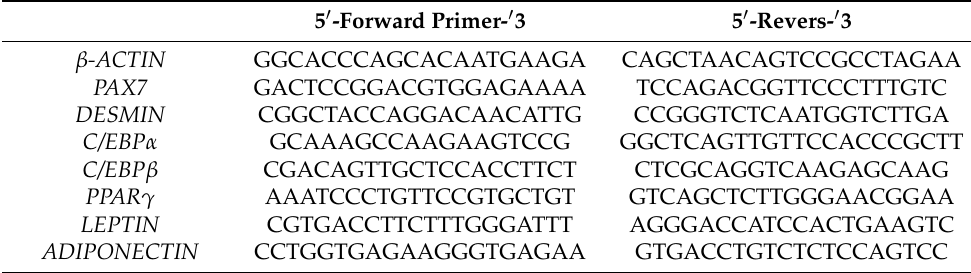
Table 1. Primer sequences for the